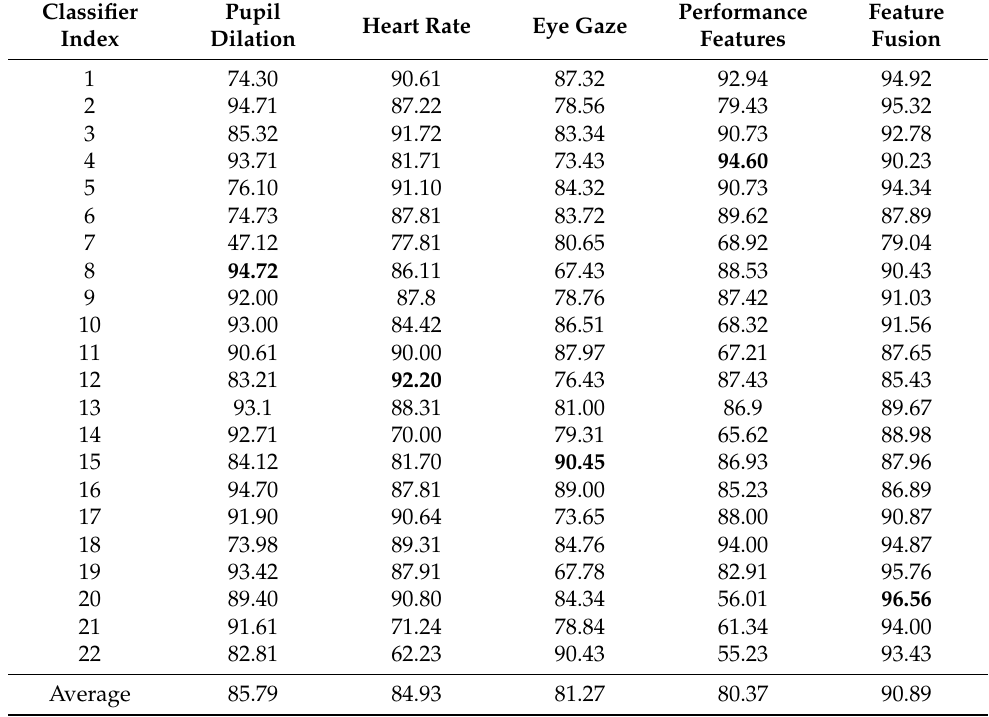
Table 5. Feature-Level Fusion and Accuracies of Single Classifiers